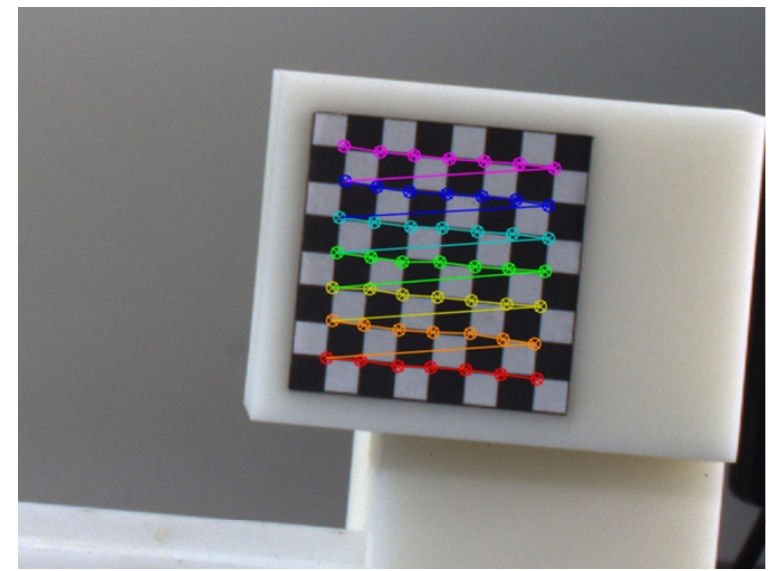
Figure 9. Image of the target obtained by the camera.